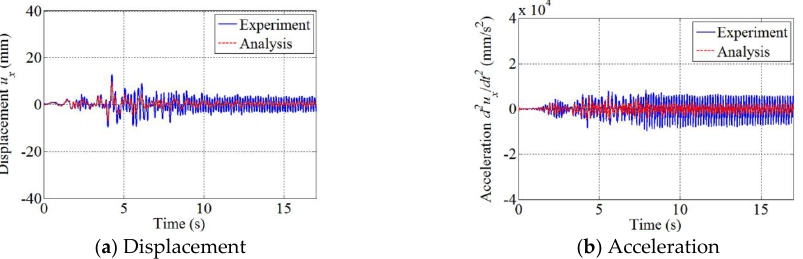
Figure 24. Numerical and experimental responses in the x direction due to the scaled Northridge earthquake of Run 11; responses sampled at point A on the third floor.